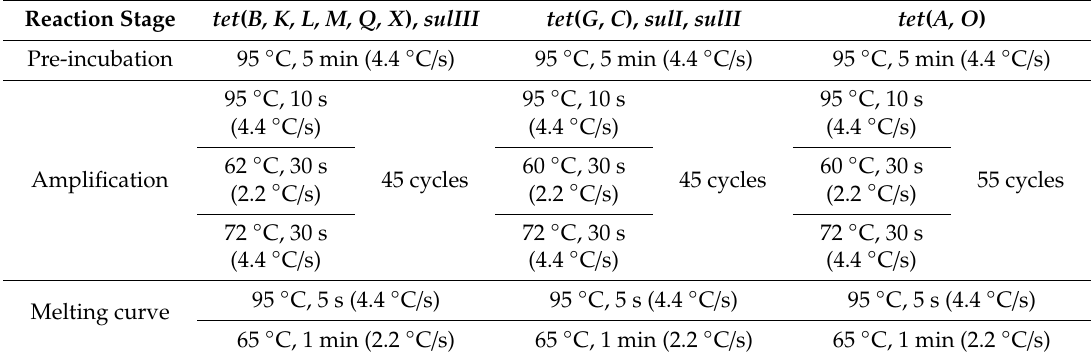
Table 6. qPCR conditions used in this